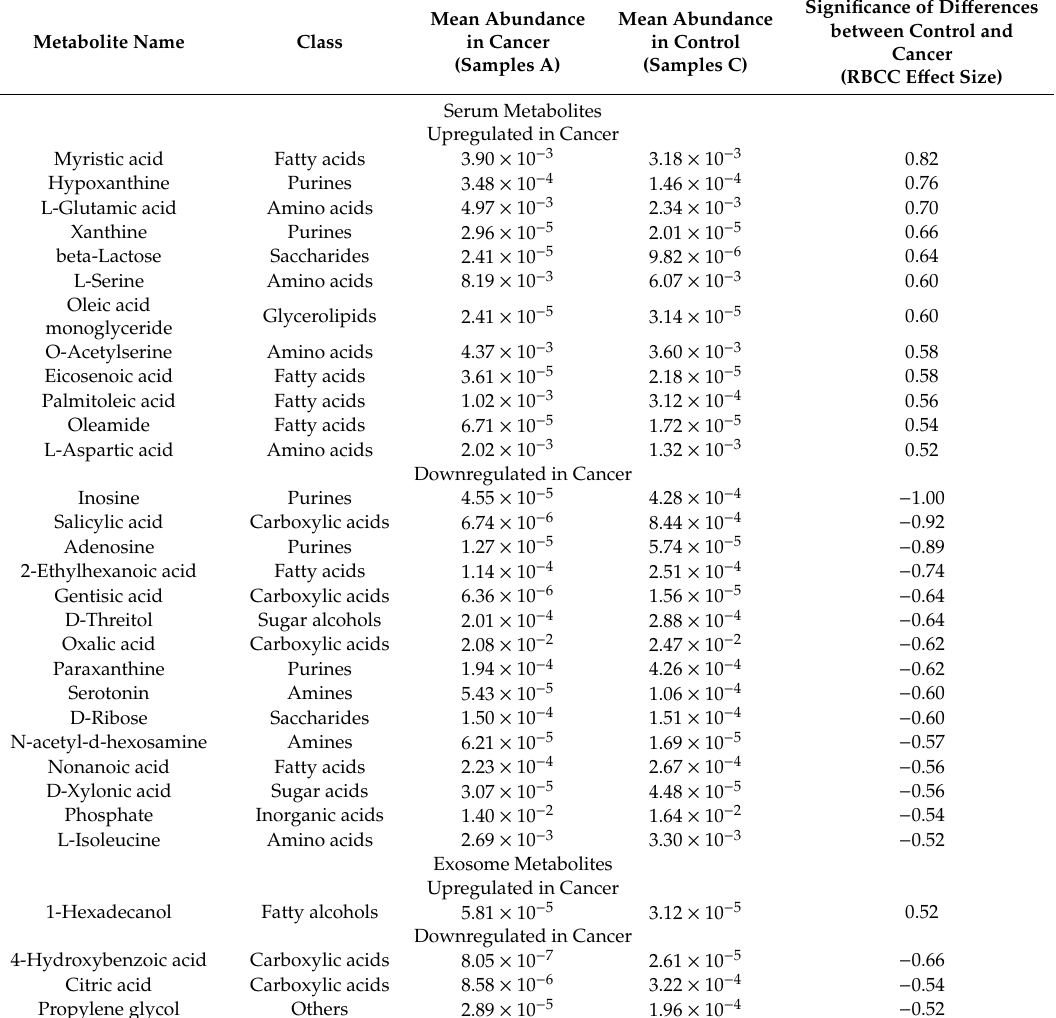
Table 1. Metabolites that di ff erentiated cancer patients and healthy individuals. Listed are compounds where di ff erences between head and neck cancer (HNC) patients (samples A) and healthy